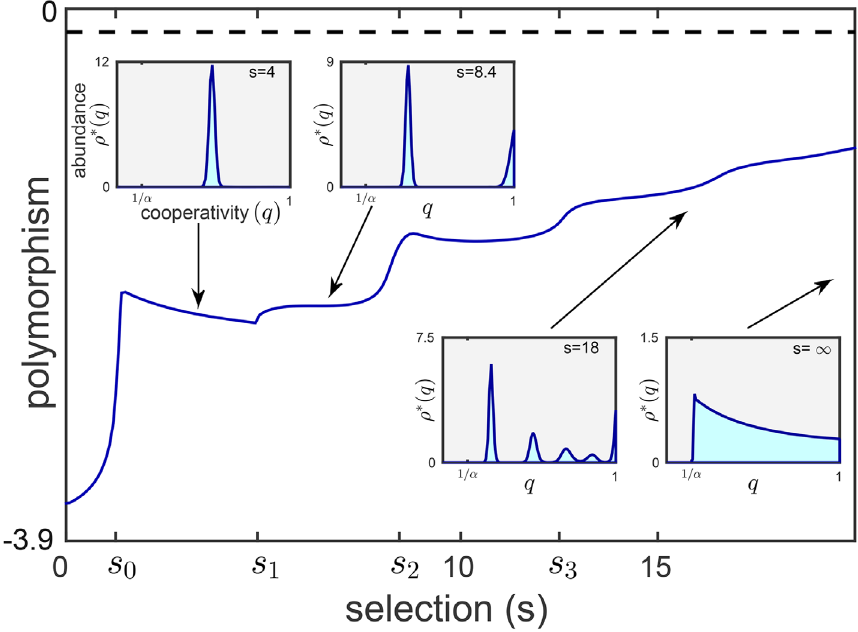
Fig 3. From monomorphic to polymorphic populations. When local selection is weak ( s < s 1 ), a single trait magnitude dominates at steady state (left inset). For stronger local competition, when s surpasses s 1 , two morphs with distinct trait magnitudes coexist (second inset). For even larger s , the steady state population becomes more and more polymorphic as more trait values coexist (third inset), until the entire spectrum 1/ α < q (cid:3) 1 is stably populated when s is very large (right inset). The width of the packs corresponds to the mutation load, where no mutations implies sharp, zero-width peaks. The increased number of coexisting morphs, which appear at each s i , implies greater steady state polymorphism (main plot), which we R 1 r ð q Þ ln ð r ð q ÞÞ dq , where a maximal possible measure as the distribution ’ s entropy (given by H ð r ð q ÞÞ ¼ (cid:2) 0 value H = 0 that is exhibited when ρ ( q ) = 1). The polymorphism in our model asymptotically approaches H 1 = − ln 2 α /(2 α ) (dashed line) as s ! 1 . Parameters: α = 2.5, ^ a ¼ 3 , μ = 4, F ( q ) = − q , y -axis 2 [ − 3.9, 0], Δ q = 0.01.